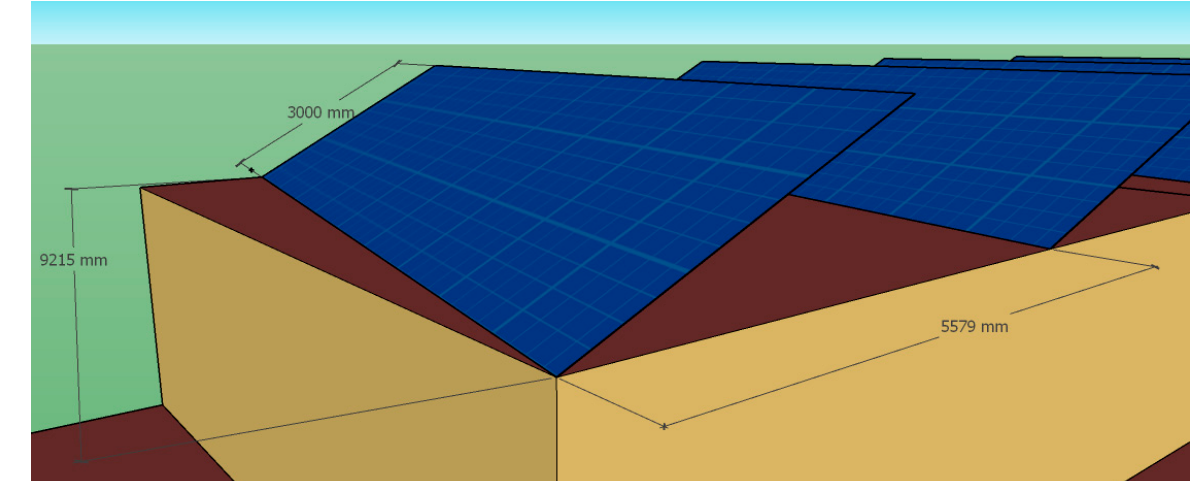
Figure 12. Dimensions and tilt angle of photovoltaic panels.